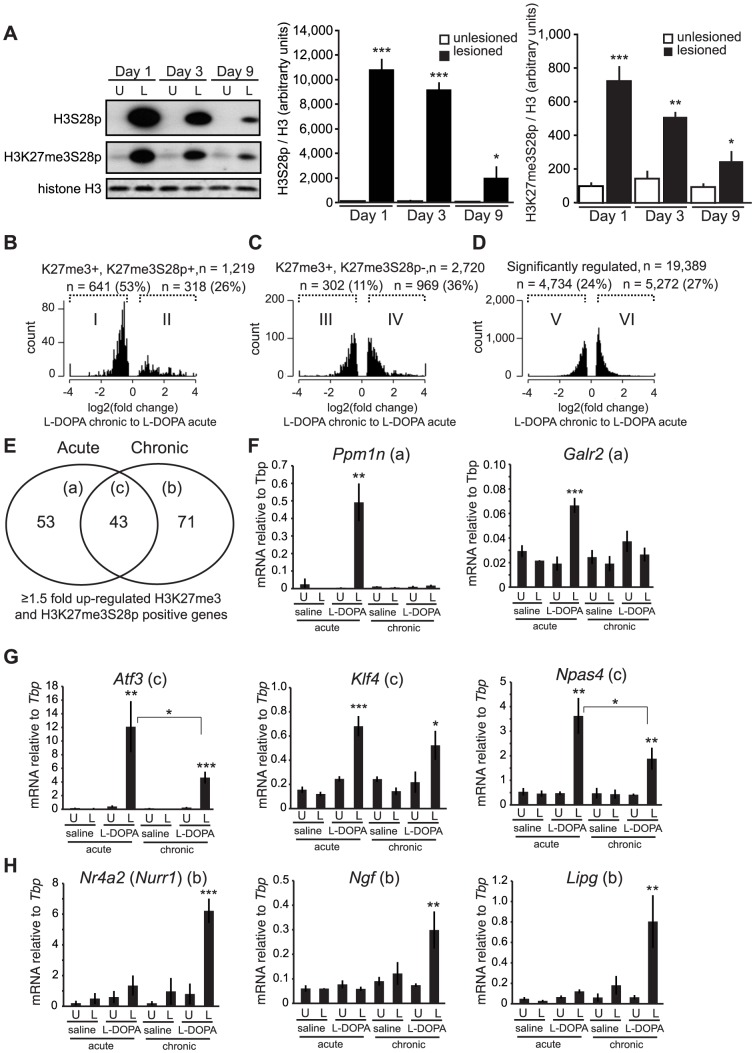
Chronic administration of L-DOPA decreases the induction of H3K27me3S28p and alters the transcriptomal response to L-DOPA.A) L-DOPA increased H3S28p and H3K27me3S8p in the lesioned striatum that progressively decreased following subsequent administrations (H3S28p: lesion x day interaction: F(2,25) = 38.17, p<0.0001; H3K27me3S28p: lesion x day interaction: F(2,24) = 11.42, p = 0.0003). *** p<0.001, ** p<0.01, * p<0.05 vs unlesioned hemisphere of the same day. n = 3–6 per condition. Data are means ±S.E.M. B–D) Histograms of differentially expressed transcripts in lesioned striata after chronic L-DOPA compared to acute L-DOPA, from H3K27me3S28p positive and H3K27me3 positive genes (B), from H3K27me3S28p negative but H3K27me3 positive genes (C), and from genes regardless of specific histone marks (D). E) Venn-diagram showing number of genes induced exclusively by acute (53; subgroup a) or chronic (71; subgroup b) and genes commonly induced after both acute and chronic L-DOPA administration (43; subgroup c). F–H) mRNA levels of (F) Ppm1n, Galr2, (G) Atf3, Klf4, Npas4, (H) Nurr1, Ngf, Lipg relative to Tbp in unlesioned and lesioned striata of acutely or chronically saline or L-DOPA injected mice determined by RT-qPCR. n = 3 mice per condition, unlesioned and lesioned striata respectively. Data are means ±S.E.M of the biological triplicates. *** p<0.001, ** p<0.01, * p<0.05. Small letters a–c following the gene names in brackets in panel F–H refers to the subgroups in the Venn diagram in panel E.